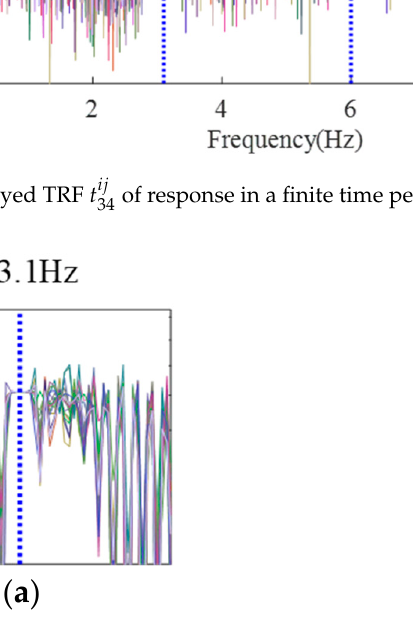
Figure 9. Local delayed TRF. ( a ) Excitation frequency 1; ( b ) excitation frequency 2.